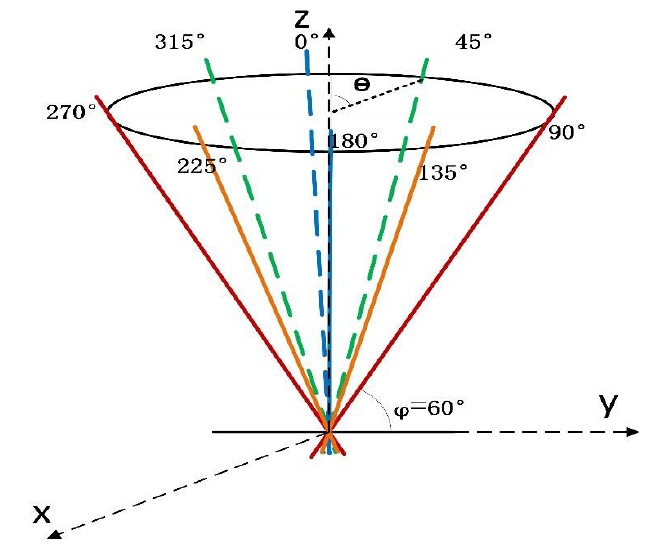
Figure 2. Schematic diagram of eight - beam coherent wind measurement Lidar.